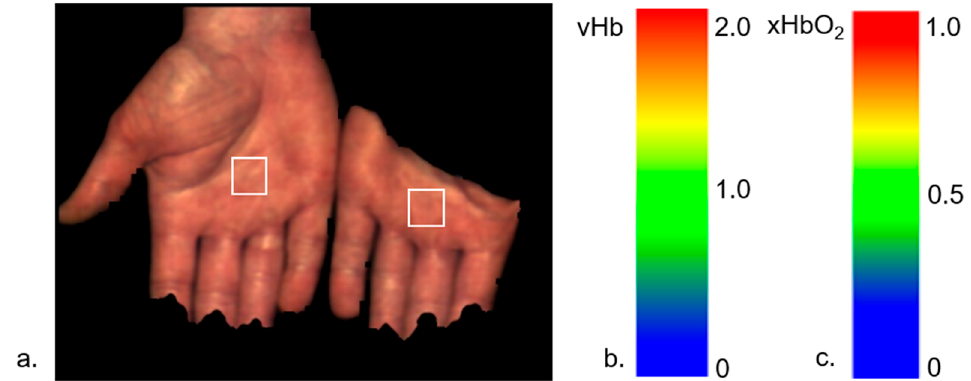
Figure 1. ( a ) Measurements of the hands in an occlusion test; right: hand of the occluded arm, left: reference hand; the white quadrates indicate the tested areas from which the profiles in Figure 3 were determined; ( b ) color scale vHb [0...2], c: color scale xHbO 2 [0…1].